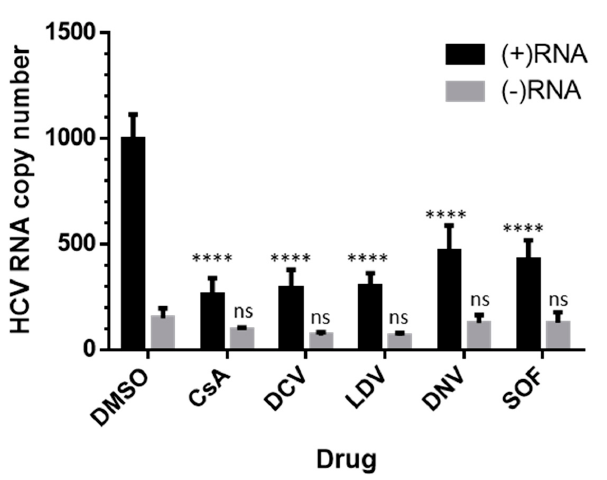
Figure 6. Strand-specific suppression of HCV RNA. Jc1/Gluc2A-virus-infected Huh-7.5.1 cells were treated with DMSO or 100 × EC 50 of compounds for 8 h. Total cellular RNA was extracted by TRIzol reagent and analyzed for HCV 5 ′ UTR RNA by RT-qPCR. The cycle threshold (CT) values were converted to copy numbers based on the standard curve of the Jc1/Gluc2A-genome-encoded plasmid. The data are shown for drug effects on HCV (+)RNA (black) and HCV ( − ) RNA (grey). Each data point represents the average value of 3 individual experiments and the error bars represent the SEMs. Statistical analysis was performed using 2-way ANOVA with Tukey’s post hoc test to compare samples within the (+) RNA group or ( − ) RNA group. ns, not significant; **** p < 0.0001. DCV, daclatasvir; DNV, danoprevir; CsA, cyclosporin A; SOF, sofosbuvir; LDV, ledipasvir.